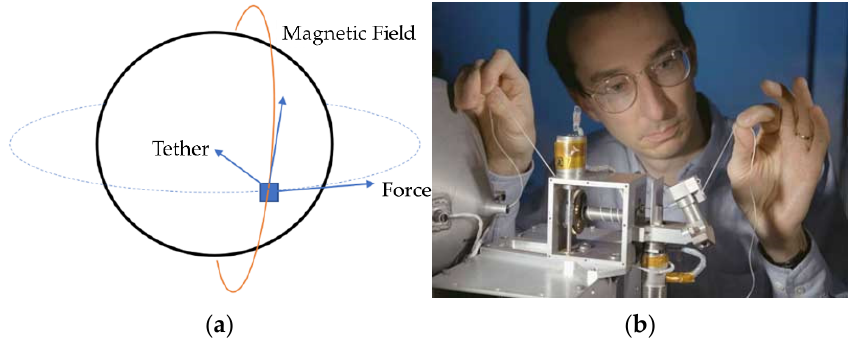
Figure 1. ( a ) Tether orientation for reboost. ( b ) Les Johnson, a scientist at Marshall Space Flight Center inspects nonconducting part of a tether [25].